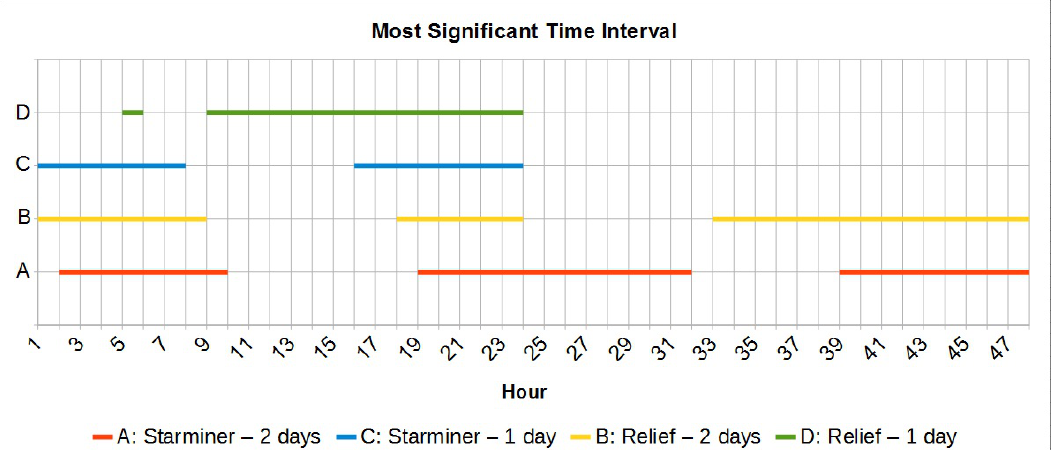
Figure 8. Most significant time interval analysis.